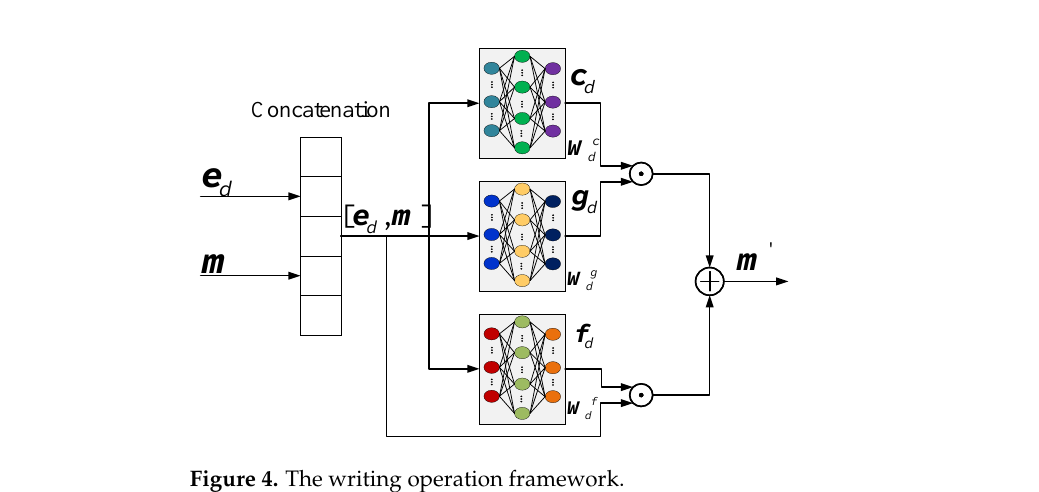
Figure 4. The writing operation framework.